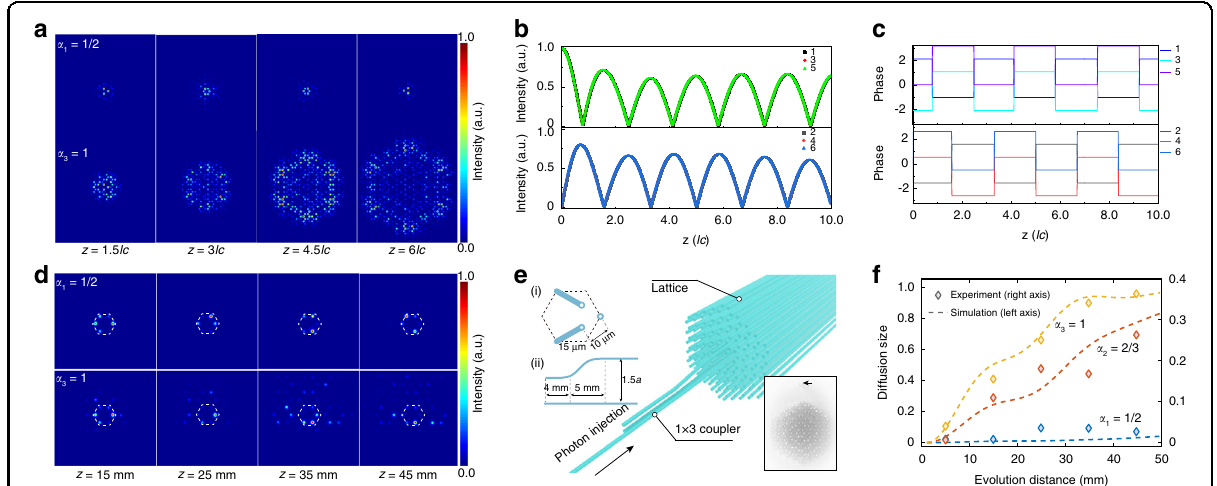
Fig. 3 The bound capability of optical vortices in cosmic strings with gauge fi elds. a and d are respectively the theoretical calculated evolution and experimental results with different propagation distances in the cosmic string ( α 1 = 1/2) and fl at space ( α 3 = 1). The white dashed hexagon line indicated the innermost ring site. b and c are respectively the intensity and phase distribution as the evolution among the six sites in the innermost ring layer. e is the experimental schematic for exciting a series of waveguides in the innermost ring layer around the cosmic string. f is the diffusion size as the evolution distance in the cosmic string and fl at